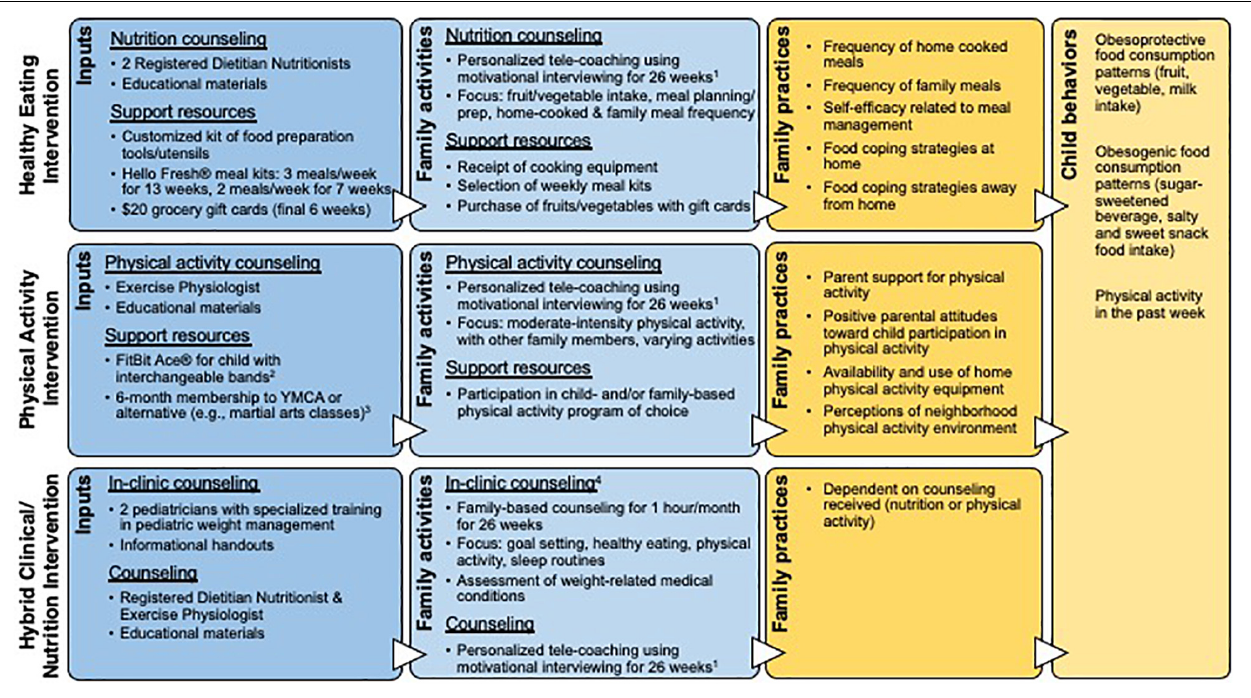
FIGURE 1 | Logic models for the three interventions, depicting intervention inputs, outputs (family activities), short-term outcomes (family practices), and medium-term outcomes (child behaviors). 1 Healthy eating and physical activity intervention counseling components included a 1-h initial session, 30-min sessions weekly over weeks 2–13 and biweekly over weeks 14–20, and monthly 15-min calls in weeks 21–26. The hybrid intervention included one telehealth coaching session per month over 26 weeks. 2 FitBit R (cid:13) provided to motivate child participants to engage in and monitor their physical activity and as a counseling tool; data were not used as a behavioral outcome. 3 The YMCA membership was modified from individual to family membership in September 2019 to increase enrollment. 4 Clinical costs were covered by Geisinger Health Plan, which includes a medical assistance